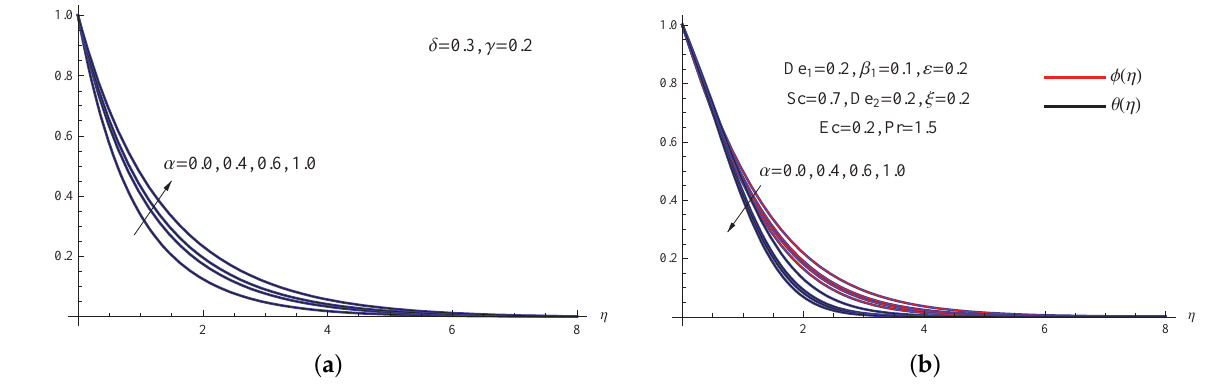
Figure 2. ( a ) f (cid:48) ( η ) for picked α . ( b ) θ ( η ) and φ ( η ) for picked α . The impact of the δ parameter on the velocity profile, temperature profile, and con- centration profile is shown in Figure 3. The heightening values of the δ parameter slightly improve both the temperature θ ( η ) and the concentration fields φ ( η ) , whereas the opposite with the same marginal effect is noticed for the velocity field f (cid:48) ( η ) . The Powell–Eyring parameter δ is physically dependent on the fluid density. As a result, as the Powell–Eyring parameter δ is increased, the density of the fluid particle increases, and the velocity profile decreases.